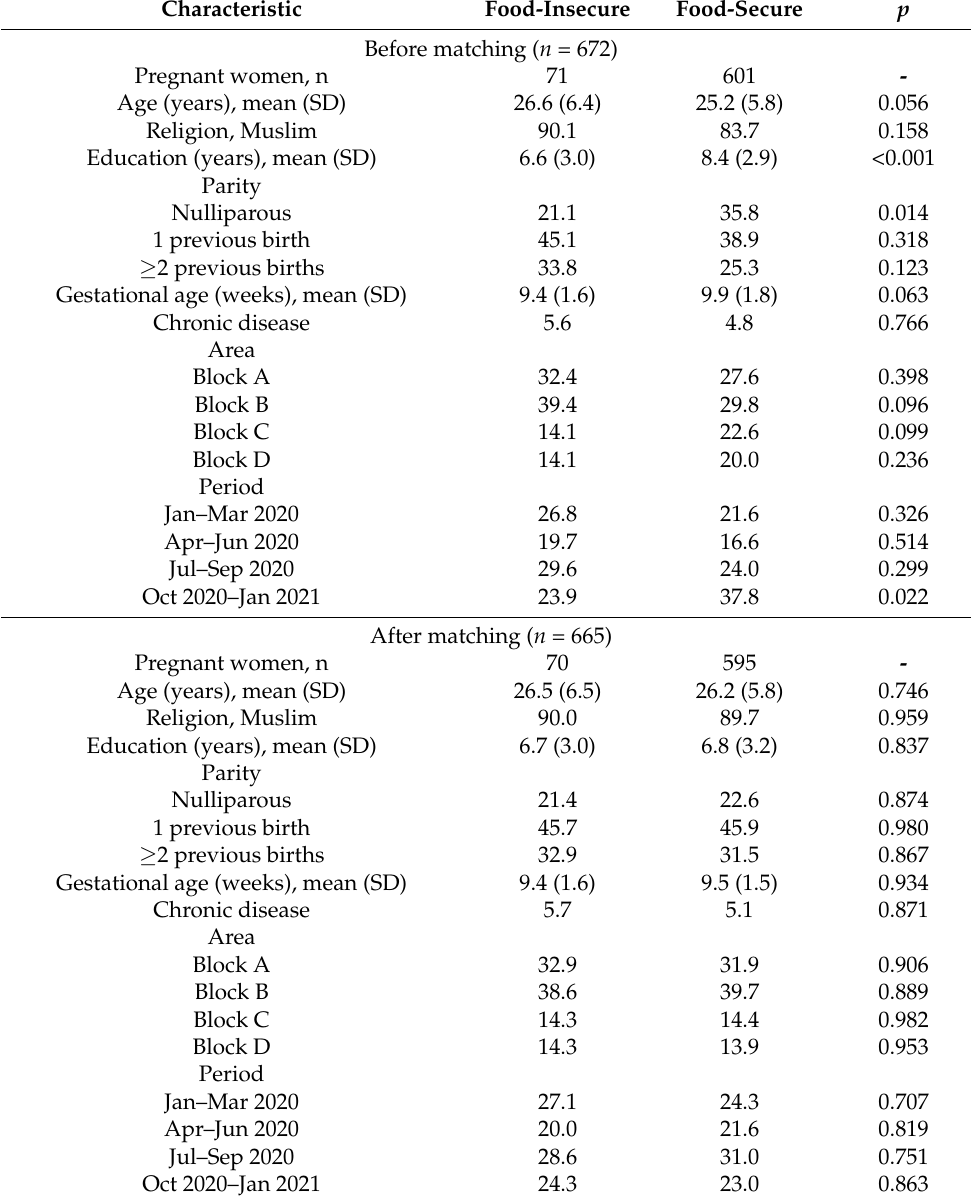
Table 1. Sample characteristics before and after propensity score matching, by household food security status 1